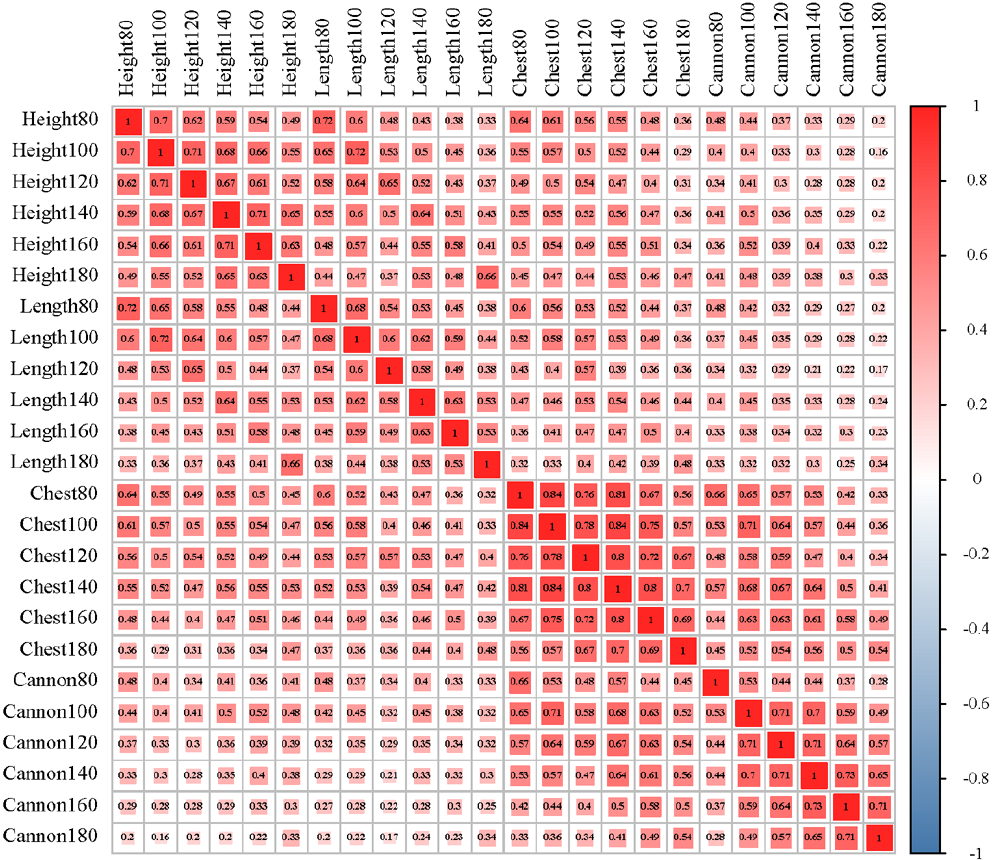
Figure 1. Correlation analysis of body height (height), body length (length), chest circumference (chest), and cannon circumference (cannon) of sheep.